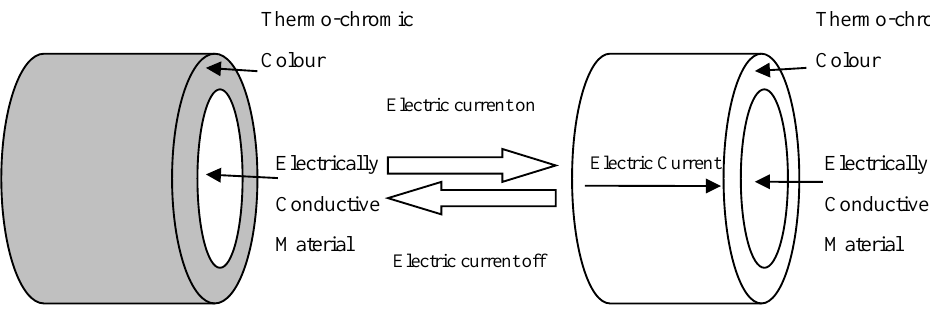
Figure 2. Conceptual model of the SMART colour-changing electrochromic yarn.